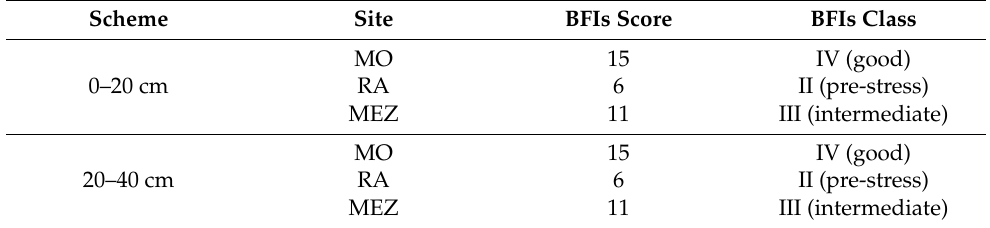
Table 4. The simplified biological fertility index (BFIs) scores and corresponding fertility classes calculated in 0–20 and 20–40 cm soil layers of processing tomato fields located in Modena (MO), Ferrara (MEZ) and Ravenna (RA) provinces, Emilia Romagna Region,